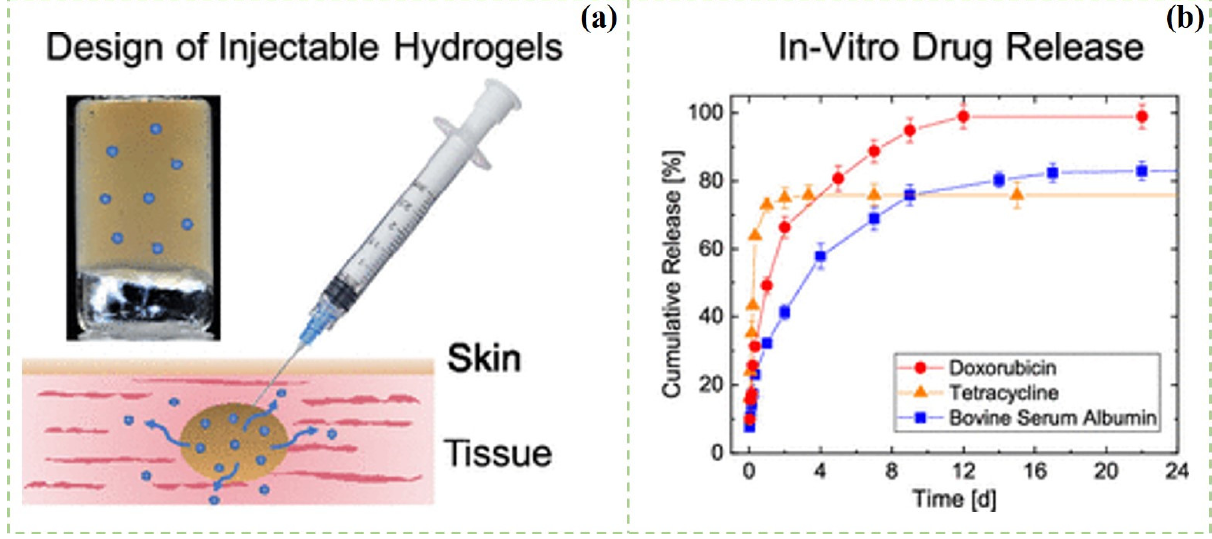
Figure 5. ( a ) Schematic illustration of the preparation of the injectable CNCs hydrogels; ( b ) In vitro drug release from CNCs hydrogels [111].